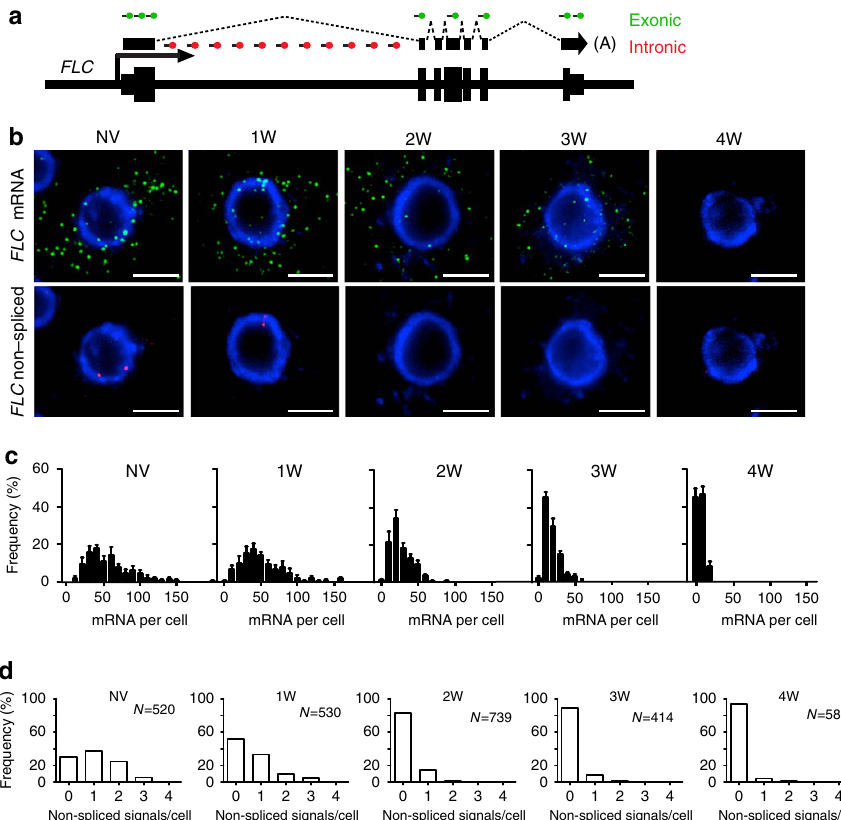
Figure 1 | Single-cell quantification of mRNA expression and FLC transcription during vernalization. ( a ) Schematic of the probes used to detect FLC transcripts: intronic (red) and exonic (green). ( b , c ) Cytoplasmic FLC mRNA decreases gradually in the cold. ( b ) Representative images of cells showing the gradual decrease of FLC mRNA (green) and the reduction in nuclear non-spliced FLC transcripts (red) in the cold. DNA labelled with DAPI (blue). Scale bar, 5 m m. ( c ) Frequency distribution of FLC mRNA molecules per cell in non-vernalized plants (NV) and after different weeks of cold (1W, 2W, 3W, 4W). ( d ) Quantification of active sites of transcription as judged by non-spliced signal at the time points depicted in c . N ¼ number of cells analysed. All error bars are þ / (cid:2)